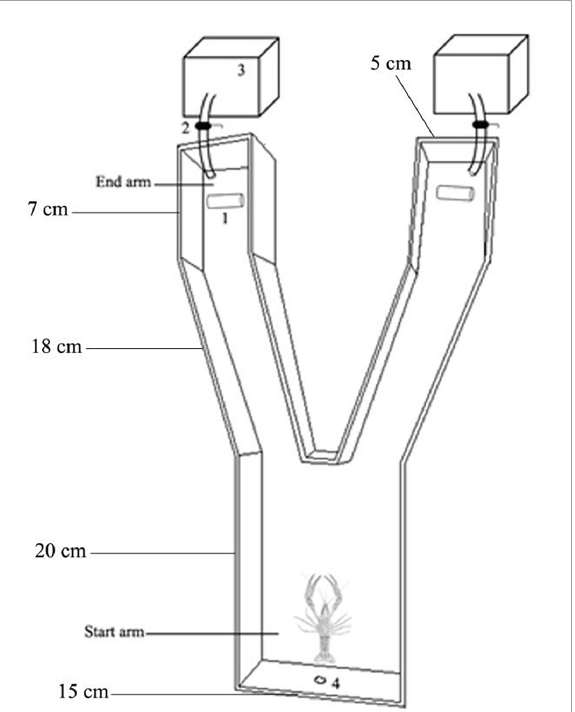
FIGURE1 The behavioral device: Y-maze. The height of Y-maze is all 5 cm. The Y-maze was symmetrical on both sides. 1: cylindrical sponge block, 2: flow meter, 3: water box, and 4: drain